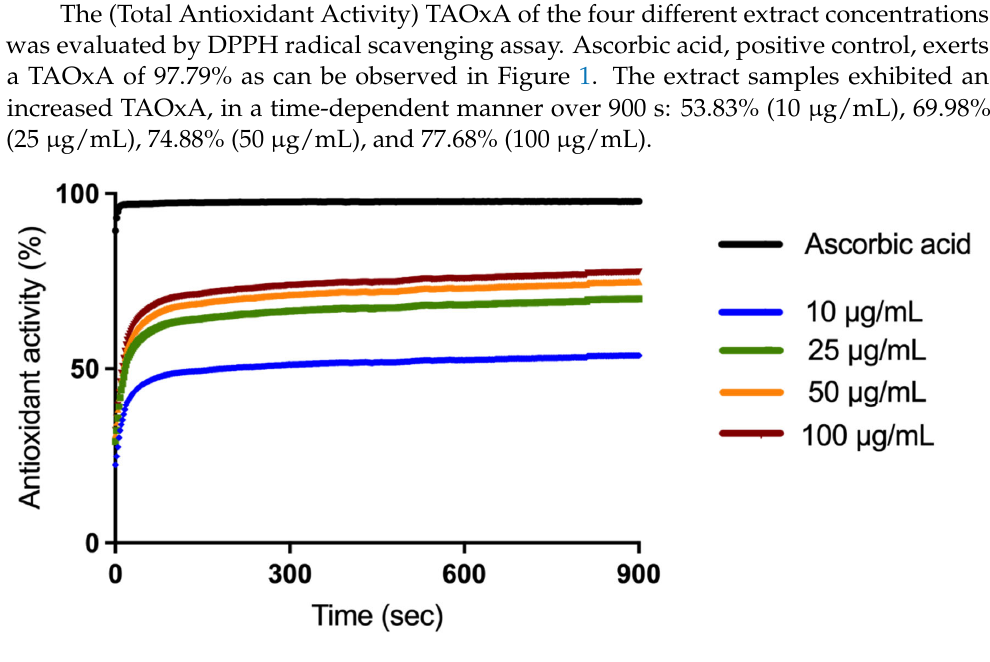
Figure 1 . Time ‐ dependent antioxidant activity of the Helleborus purpurescens